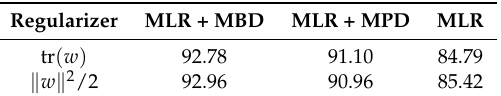
Table 10. MLR regularizer analysis on MLV.